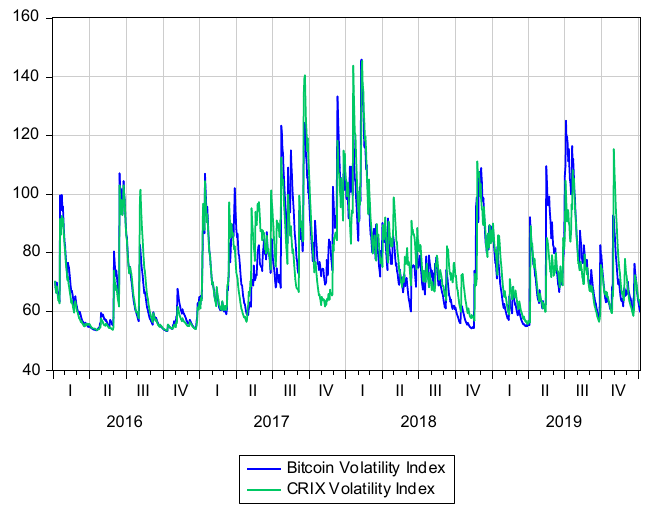
Figure 8. 30-Day GARCH(1,1) Volatility